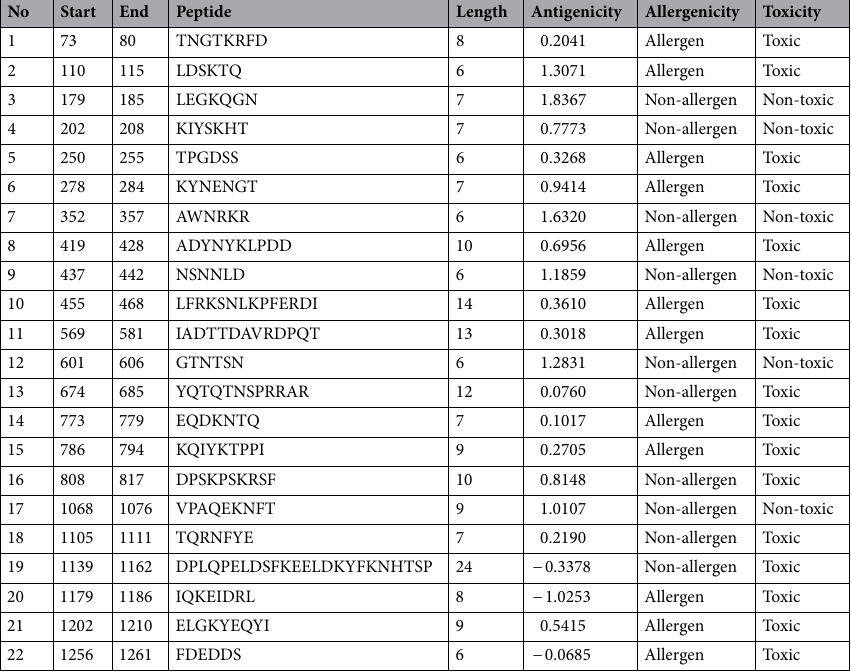
Table 3. List of good surface accessibility peptides 34